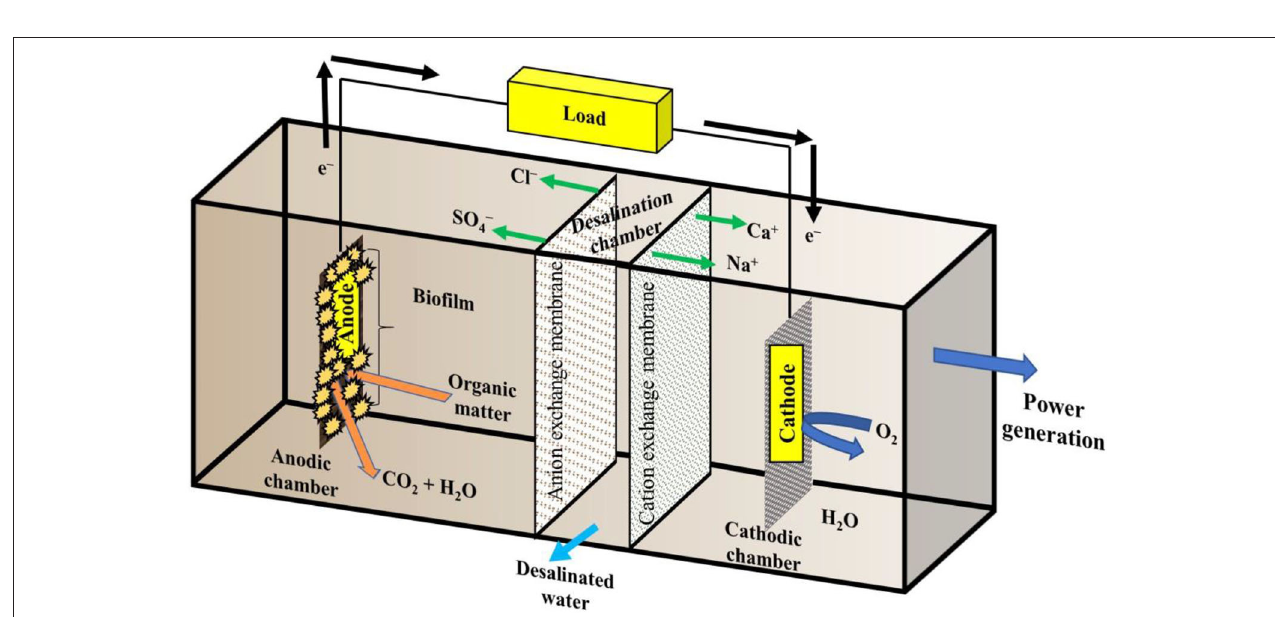
FIGURE 2 | Schematic representation of a microbial electrolysis cell setup.